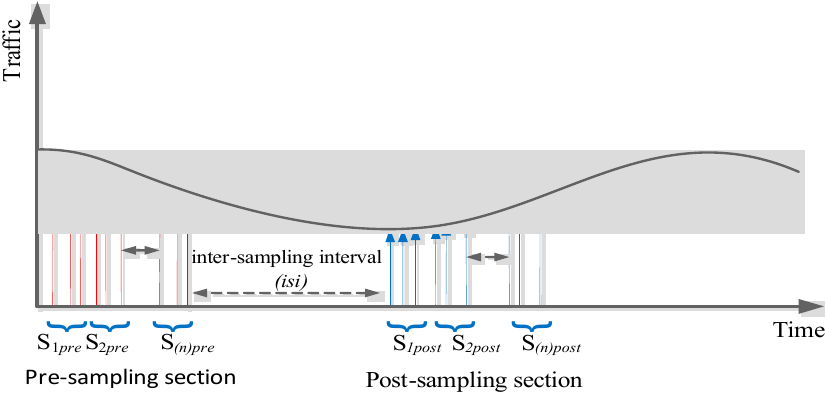
Figure 5. Traffic representations for the regression model.